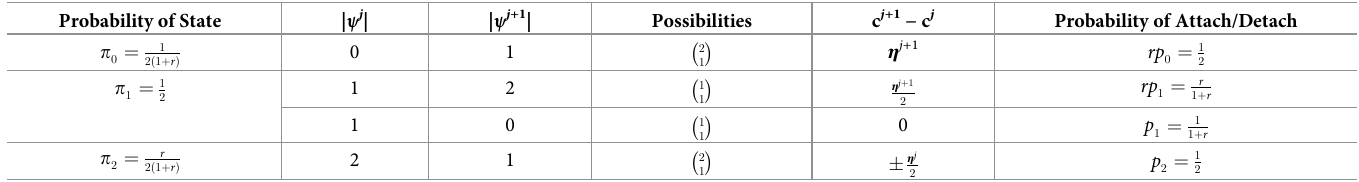
Table 1. Centroid model (n = 2) for j � 1. This table shows the probabilities of being in certain states, the probabilities of changing to different states with the number of possibilities for those changes, and the centroid location change. Probability of State